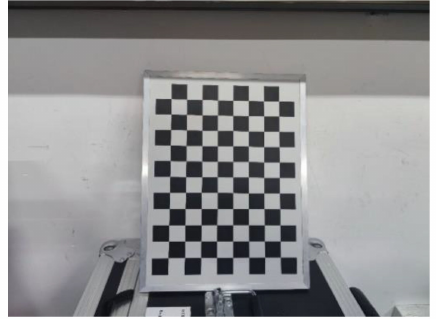
Figure 9. The board used for camera